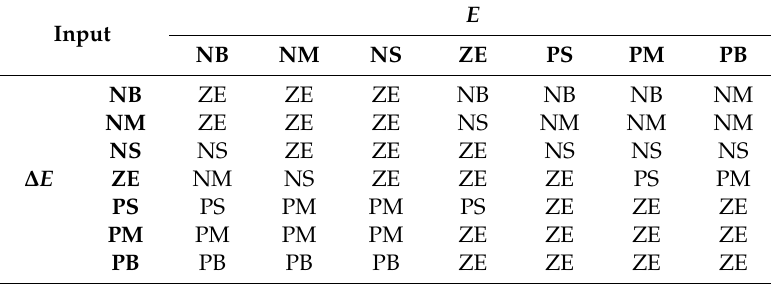
Table 1. Fuzzy logic rules for the push pull converter. NB, negative big; NM, negative medium;